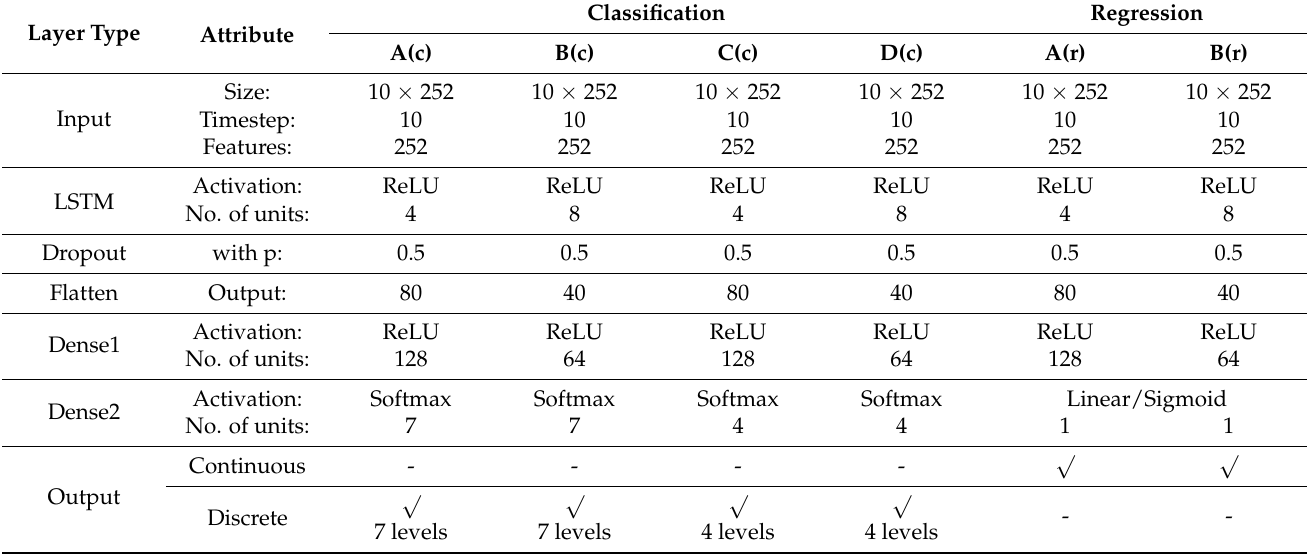
Table 3. A summary of the LSTM/LSTM-SW architectures’ configurations using data from Uni- modality. This table is also presented in our recent study